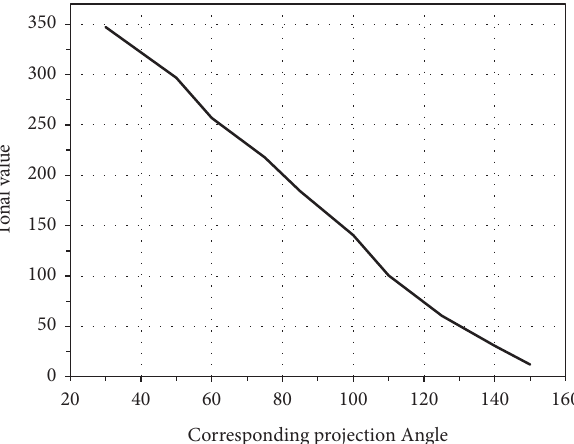
Figure 10: Corresponding relationship between hue value and projection angle of